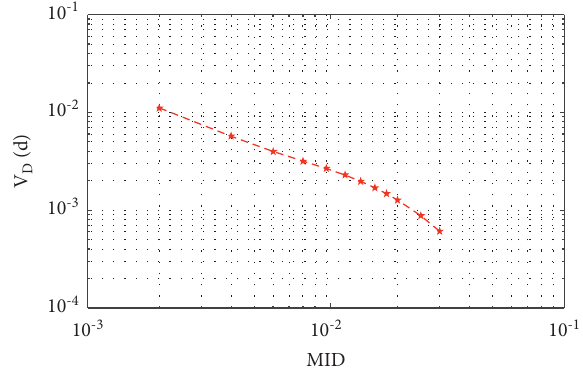
Figure 12: Seismic demand hazard curve.